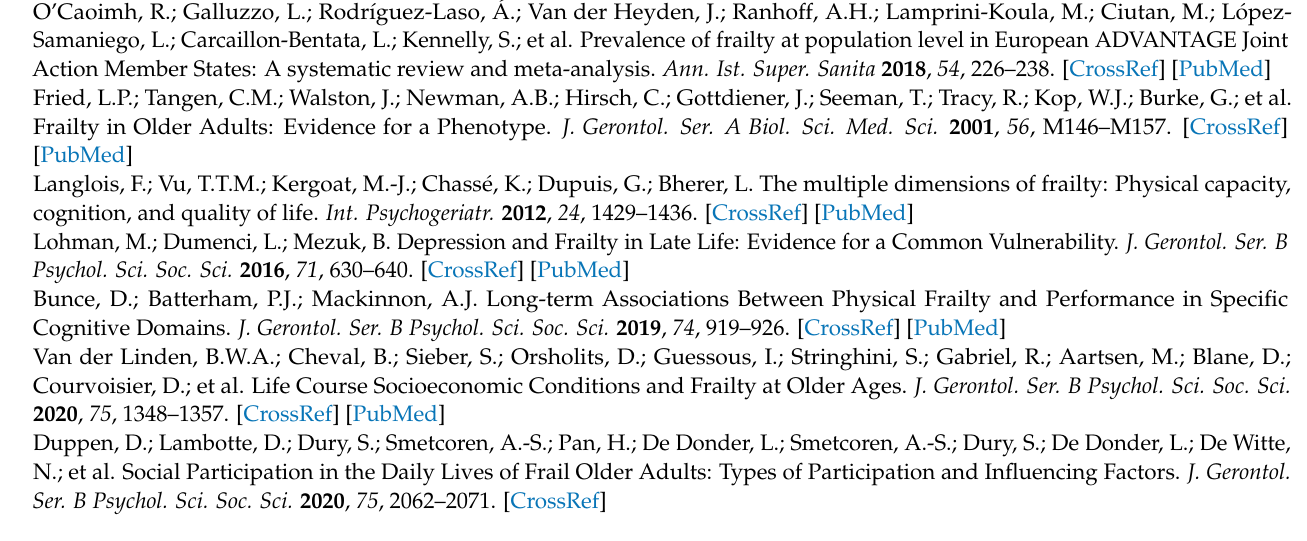
Table S4. Linear regression analysis for SF-36-PCS; Table S5. Linear regression analysis for SF-36-MCS; Table S6. Nominal regression analysis for GDS-15; Table S7. Logistic regression analysis for MMSE; Figure S1. Binary tree computed by conditional recursive partitioning of frailty classes (0 = robust, 1 = pre-frail, 2 = frail subjects), including FN1 rs7567647 genetic variant. SF-36-PCS, SF-36-MCS, GDS-15 (0–5 = no depression, 6–9 = mild depression, 10–13 = depression), MMSE, sex, age groups, BMI classes, number of daily drugs (“Drugs”), absence or presence of caregiver (NO/YES), annual income, absence or presence of leisure activities (NO/YES), and level of education (School). The variables affecting frailty are SF-36-PCS, having or not a caregiver, SF-36-MCS, and FN1 rs7567647 genetic